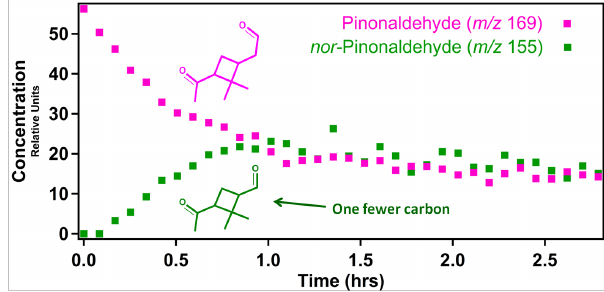
Fig. 5. SOA mass yields of organic species with vapor pressure of ∼ 10 3 µgm − 3 . n -Pentadecane (from the 10 5 µgm − 3 sequence) is Figure 5. SOA mass yields of organic species with vapor pressure of ~ 10 3 µg m -3 . n -Pentadecane (from 5 the 10 5 µg m -3 sequence) is shown as a reference. The differences in SOA mass yields between n- nonadecane 6 shown as a reference. The differences in SOA mass yields between and n- heptadecanal are not surprising. The aldehydic moiety is very reactive and causes fragmentation at high 7 n -nonadecane and n -heptadecanal are not surprising. The aldehy- NO x , while the n- nonadecane does not have relevant first-generation fragmentation paths. 8 dic moiety is very reactive and causes fragmentation at high NO x , while the n -nonadecane does not have relevant first-generation frag- mentation paths.